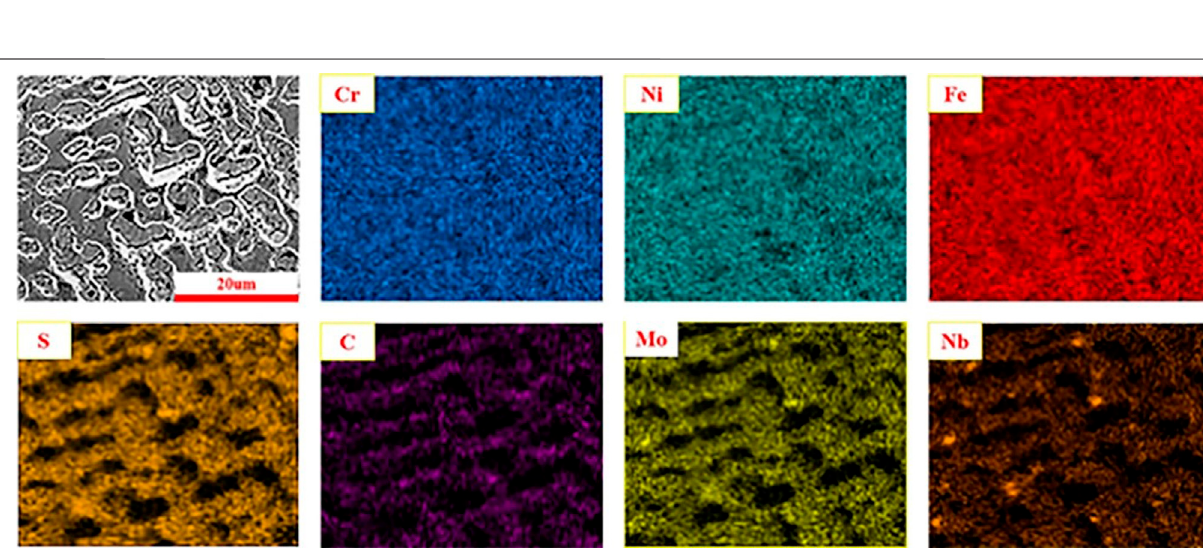
FIGURE 6 | Energy spectrum scanning of the